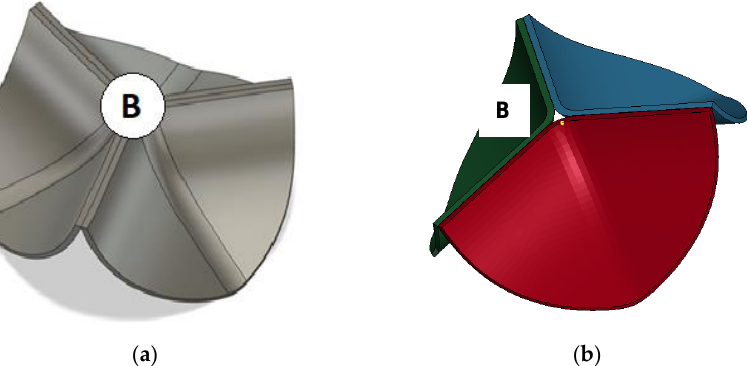
Figure 9. The location node B of the 3D model of asymmetry tri-leaflet, ( a ) In previous study [24] ( b ) In the present study.